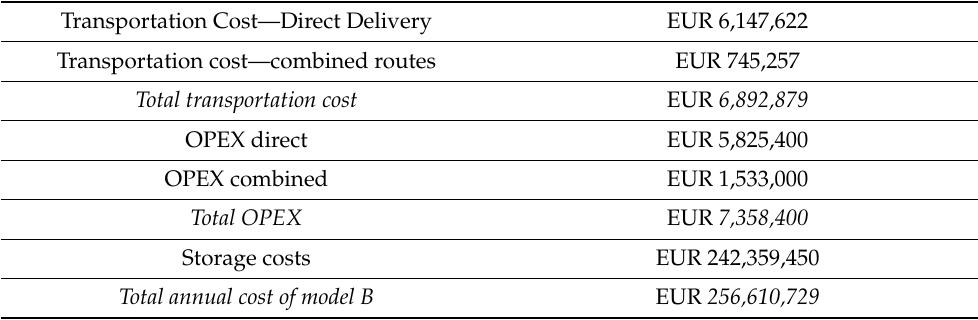
Table 6. Total annual costs of model